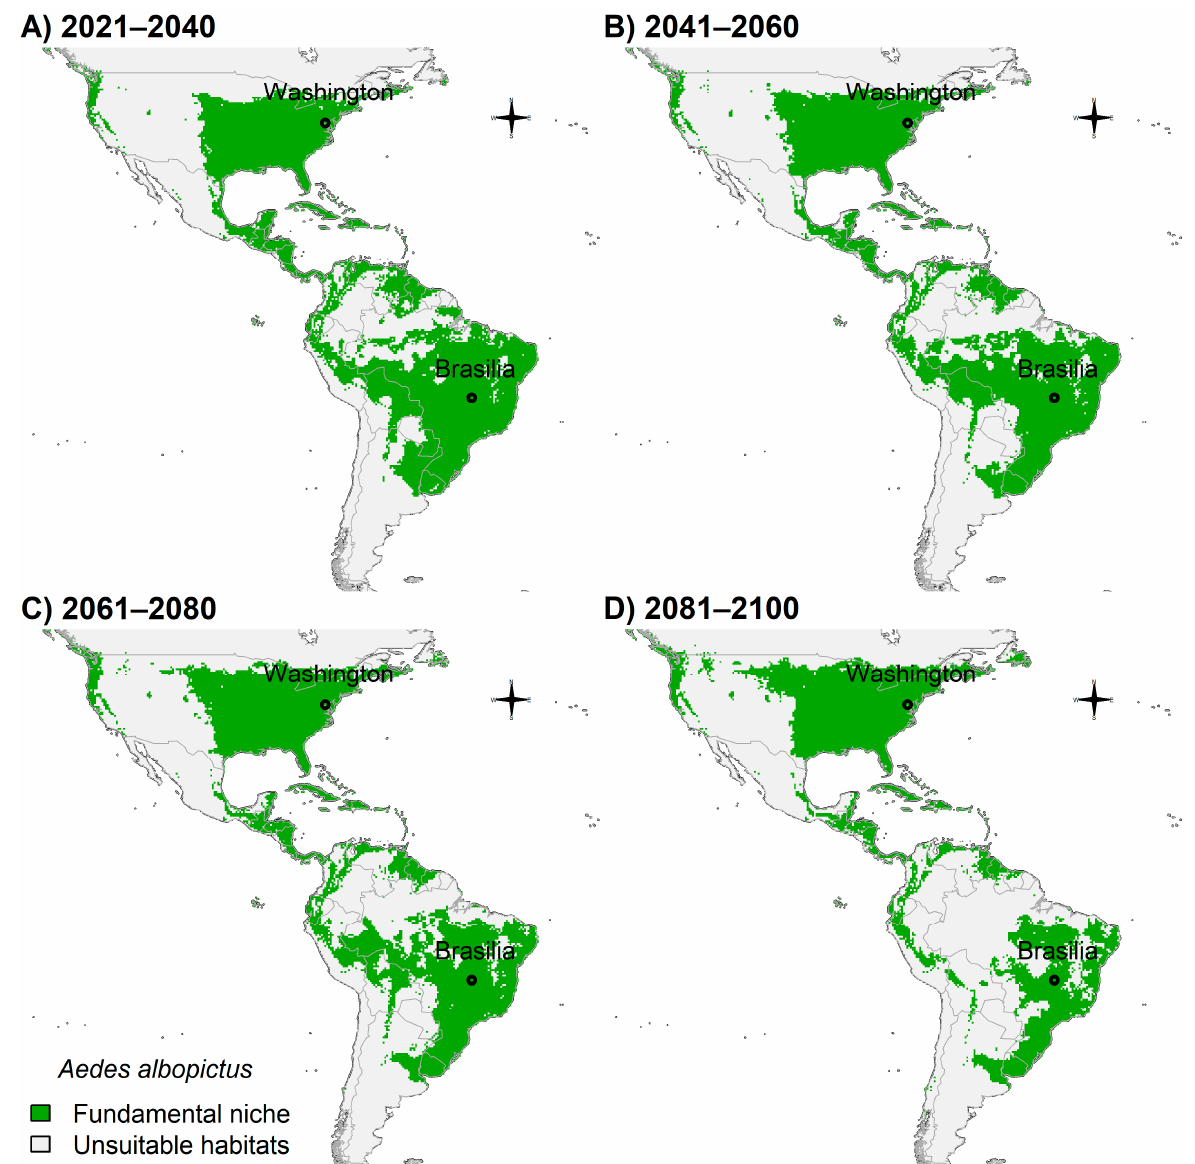
Figure 6. Potential future distribution of Ae . albopictus in Americas: ( A ) 2021–2040; ( B ) 2041–2060; ( C ) 2061–2080; and ( D ) 2081–2100. Future climate projections based on the global climate model GFDL-ESM4.1 by NOAA in the shared socio-economic pathway SSP3-7.0 of region rivalry. Loca- tions of capitals of countries were shown for reference.